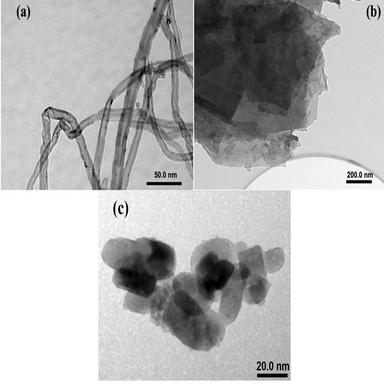
Typical TEM images of (a) MWCNTs, (b) GNP, and (c) TiO2.